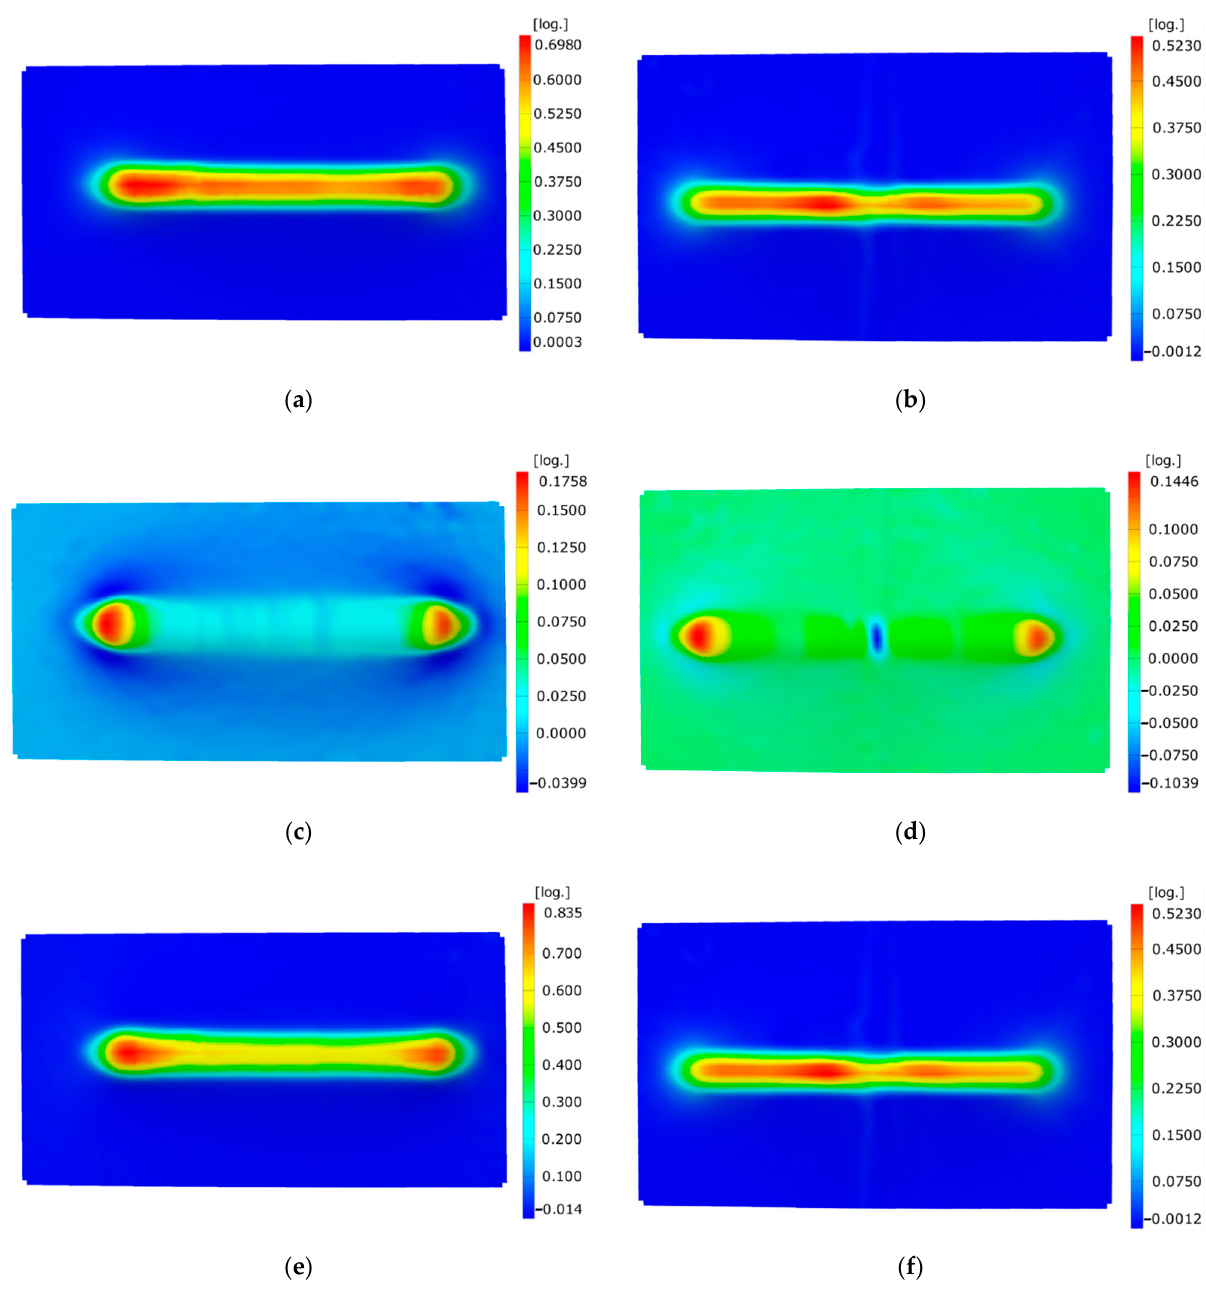
Figure 13. The major strain variation for unwelded blanks ( a ) and double side welded blanks ( b ), the minor strain variation for unwelded blanks ( c ) and double side welded blanks ( d ) and the thickness reduction variation for unwelded blanks ( e ) and double side welded blanks ( f ) for uniaxial tool path test.